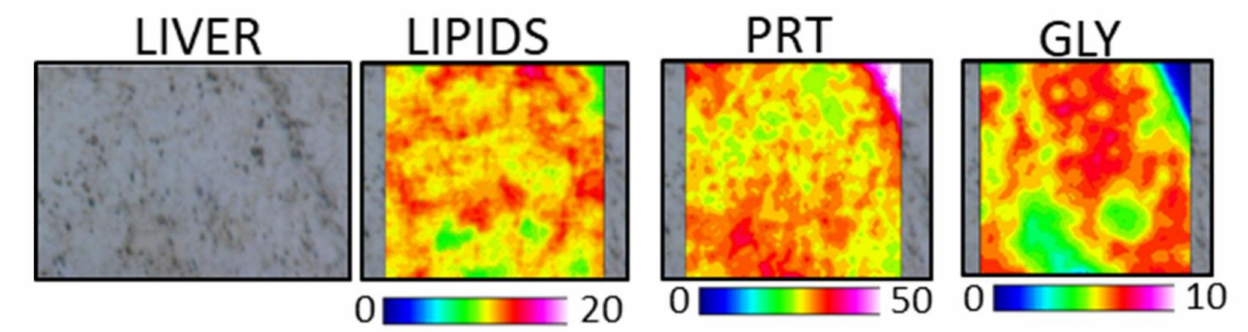
Figure 7. Hyperspectral imaging analysis of a representative section of the liver of the CF dietary group. False color images (164 × 164 µ m) representing the topographical distribution of total lipids (LIP, 0–20 color scale), proteins (PRT, 0–50 color scale), and glycogen (GLY, 0–10 color scale). Black/dark blue color represents the lowest absorbance values of infrared radiation, while white/light pink represent the highest ones.